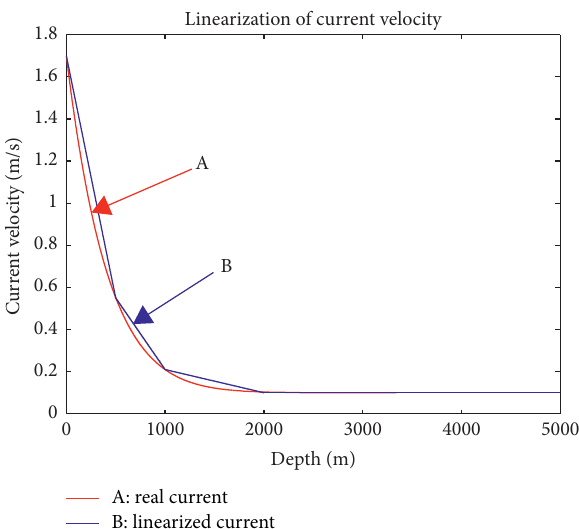
Figure 3: The current velocity curves below ocean surface.